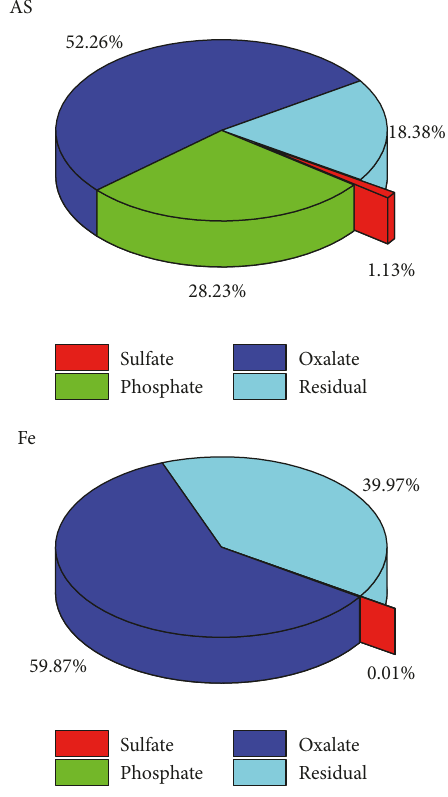
Figure 5: Distribution of As and Fe in the selective extractions.